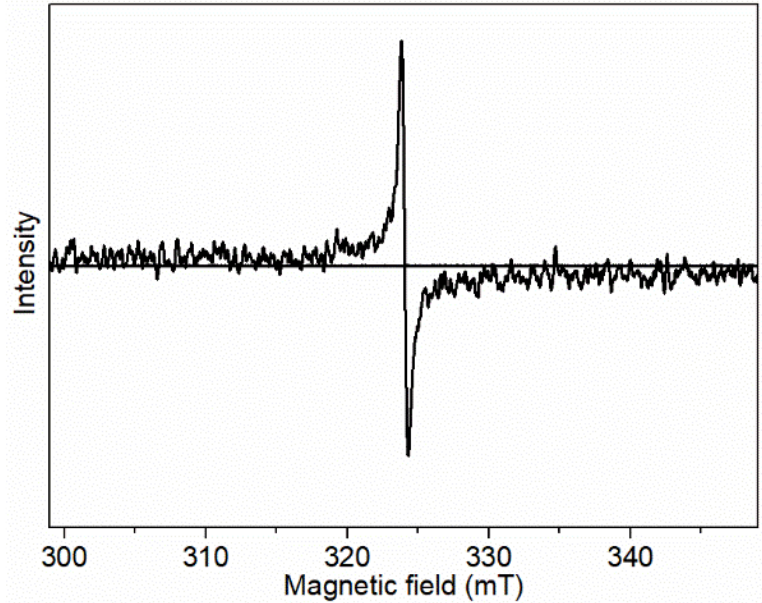
Figure 5. EPR oxygen vacancies of CF/SrTiO 3 .